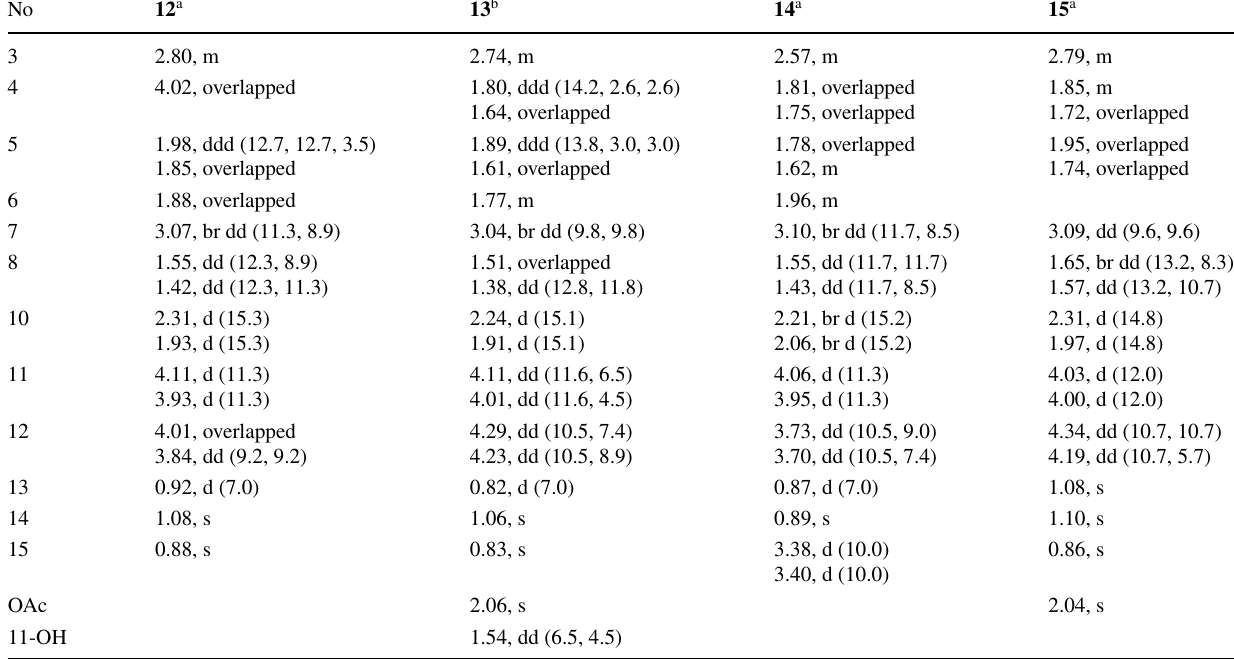
Table 3 1 H NMR spectroscopic data of compounds 12 – 15 (600 MHz, δ in ppm)